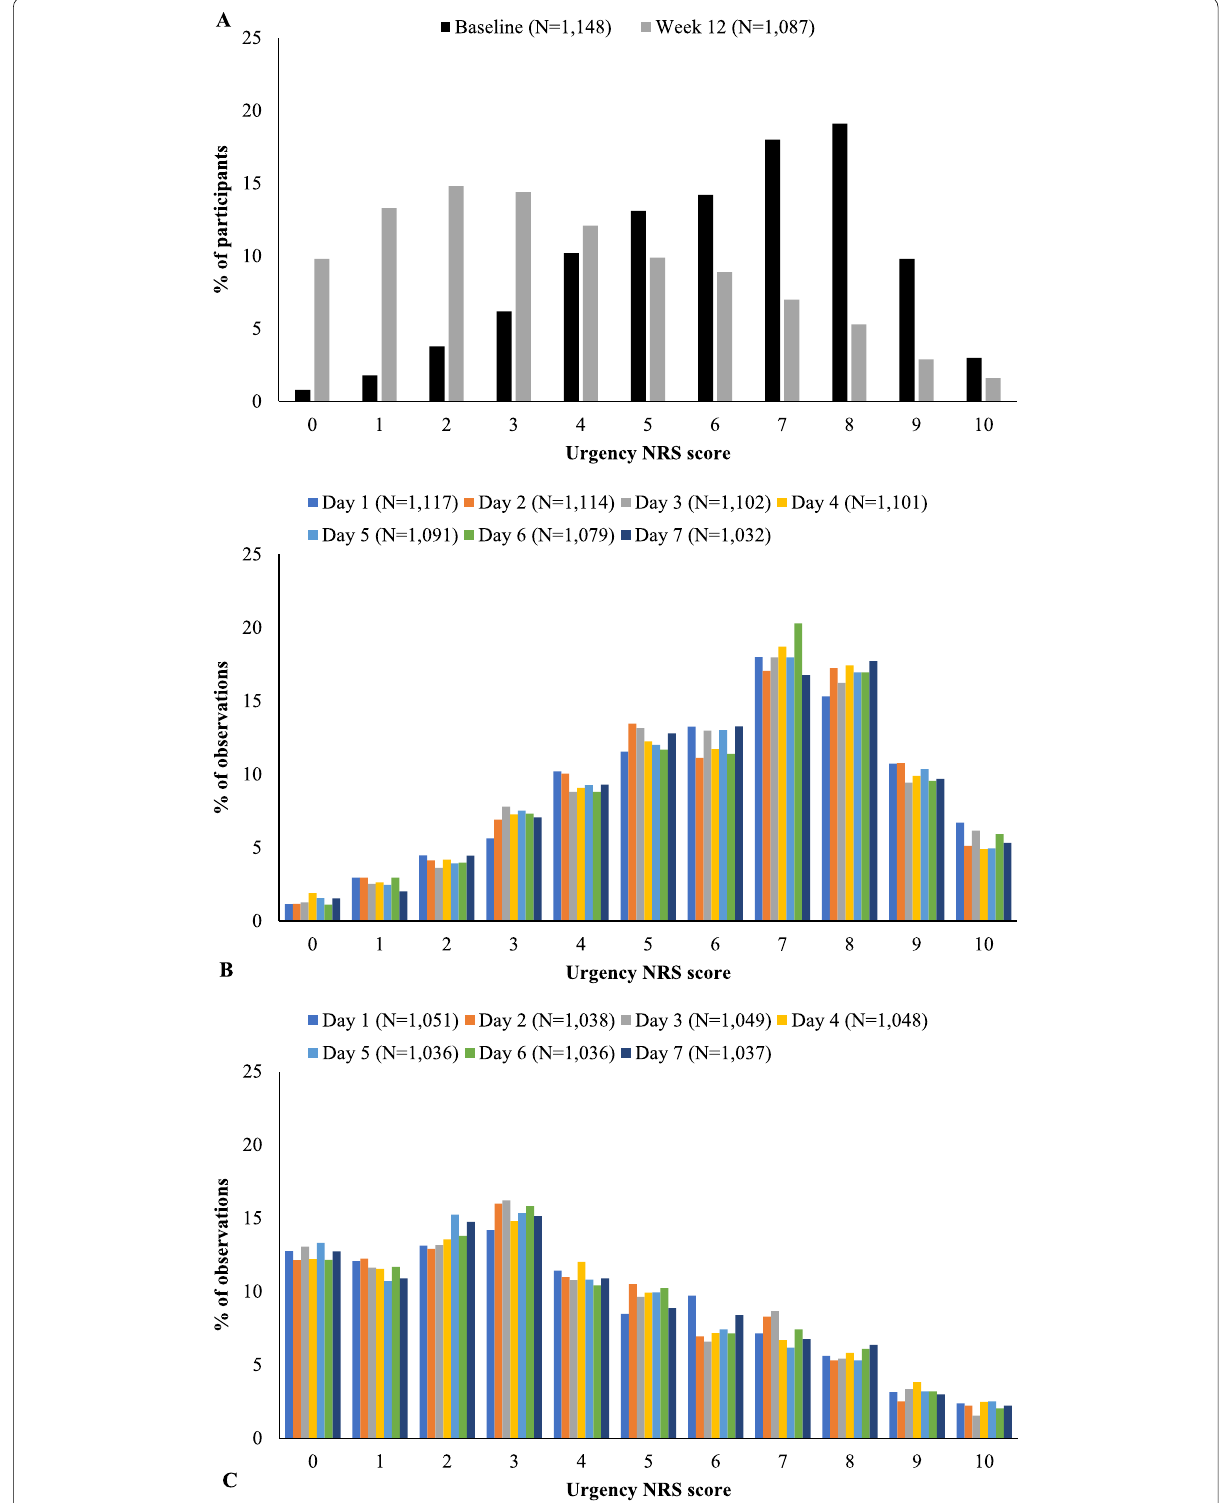
Fig. 2 Urgency NRS score distributions. A Average weekly scores, rounded to the nearest whole number. B Daily scores recorded in the 7 days prior to the baseline clinical visit. C Daily scores recorded in the 7 days prior to the week 12 clinical